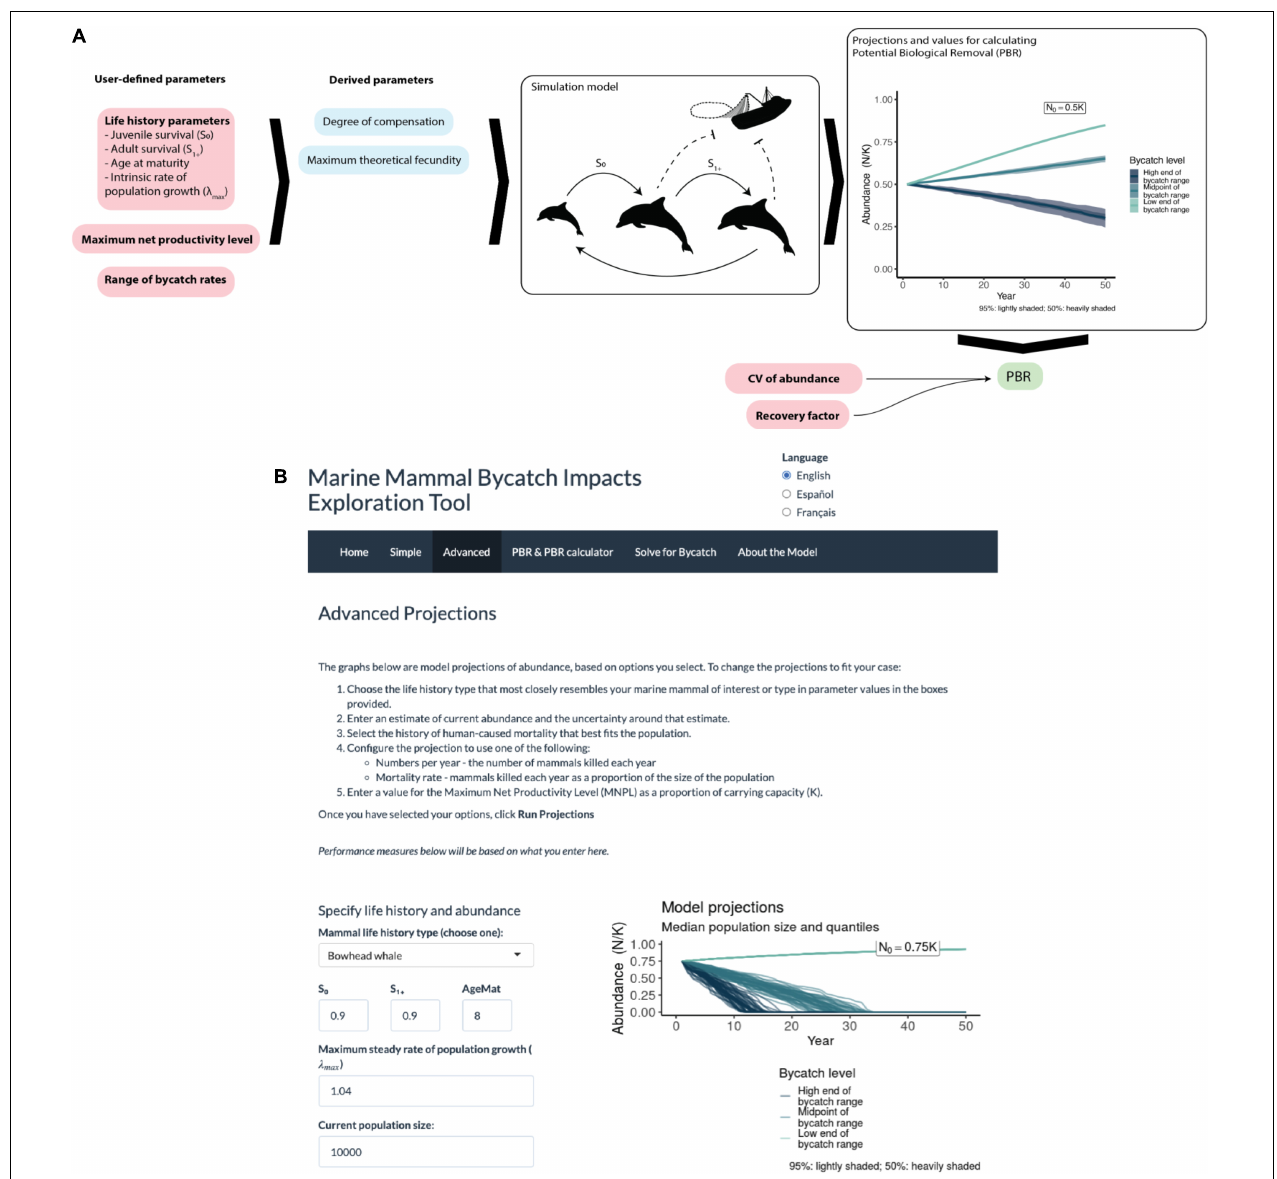
FIGURE 2 | (A) Flow of inputs and information in the Marine Mammal Bycatch Impacts Exploration Tool (MMBIET; Siple, 2021). Pink boxes indicate user-specified inputs; blue boxes indicate derived life history parameters. Users provide life history information by selecting a default life history type or by specifying parameter values manually. They also choose the Maximum Net Productivity Level (MNPL) and a range of bycatch rates to explore. The tool uses these values to conduct projections of marine mammal abundance into the future. The simulated abundance and CV of abundance selected by the user are used to calculate Potential Biological Removal (PBR). (B) Example screenshot from MMBIET. Open source code can be found at